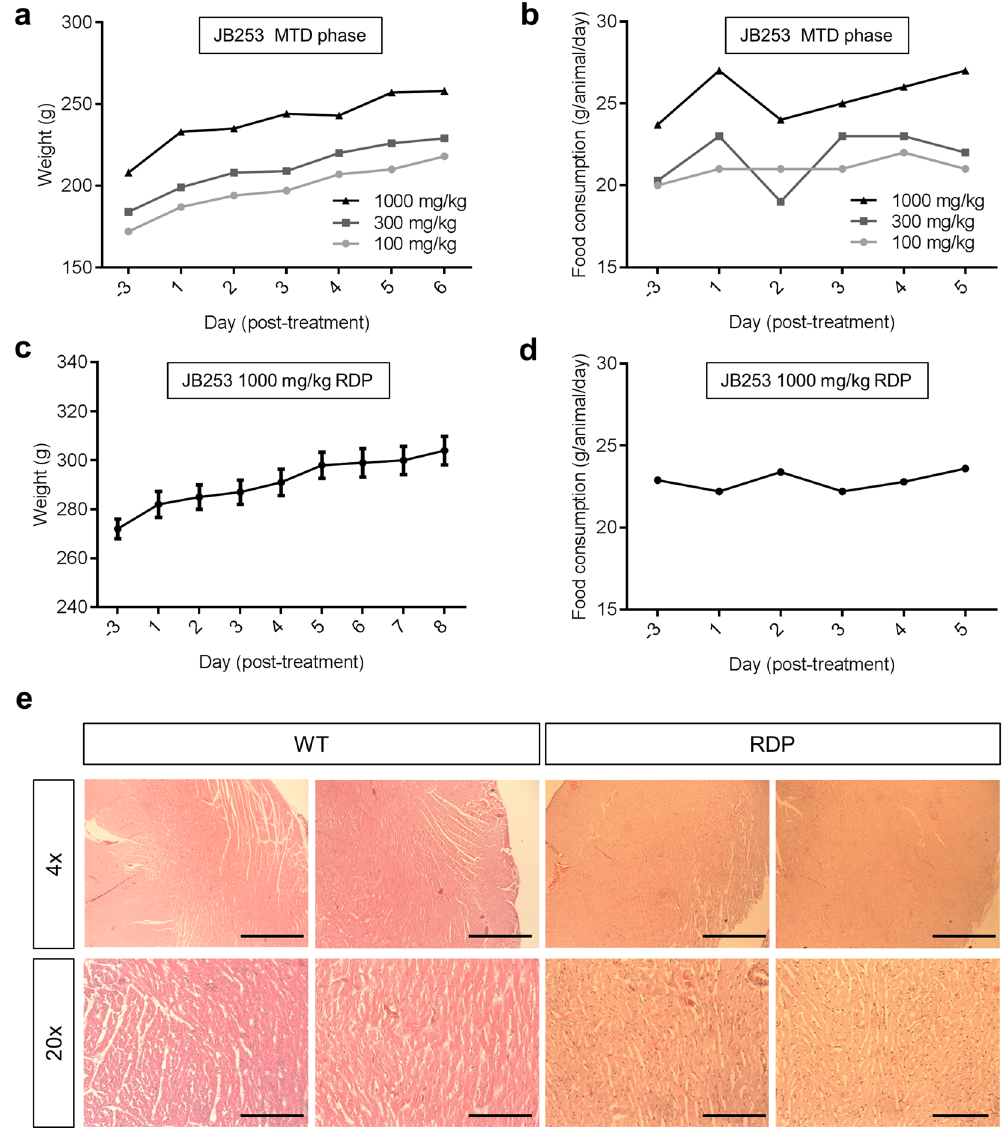
Figure 2. JB253 toxicology studies. ( a ) An animal receiving escalating doses (100–1000 mg/kg) during the maximum tolerated dose (MTD) phase did not show reductions in body weight). ( b ) As for ( a ), but food consumption (average chow consumed; n = 4 animals grouped). ( c ) As for ( a ), but showing no changes in weight during the repeated dose phase (RDP) at the maximum dose (1000 mg/kg) ( n = 5 animals). ( d ) As for ( b ), but showing no changes in food consumption per animal during the RDP at the maximum dose (1000 mg/ kg) (average chow consumed; n = 5 animals grouped). ( e ) Histopathological examination of hearts from wild-type (WT) and RDP animals was inconclusive with apparently normal cardiomyocyte morphology and no evidence of toxicity (representative images shown; n = 3–4 animals) (scale bar top = 500 µ m; scale bar bottom = 100 µ m). Animal numbers were set according to the UK Home Office, and in line with the OECD Mutual Acceptance of Data Agreement. Values represent mean ± SEM where grouped values are